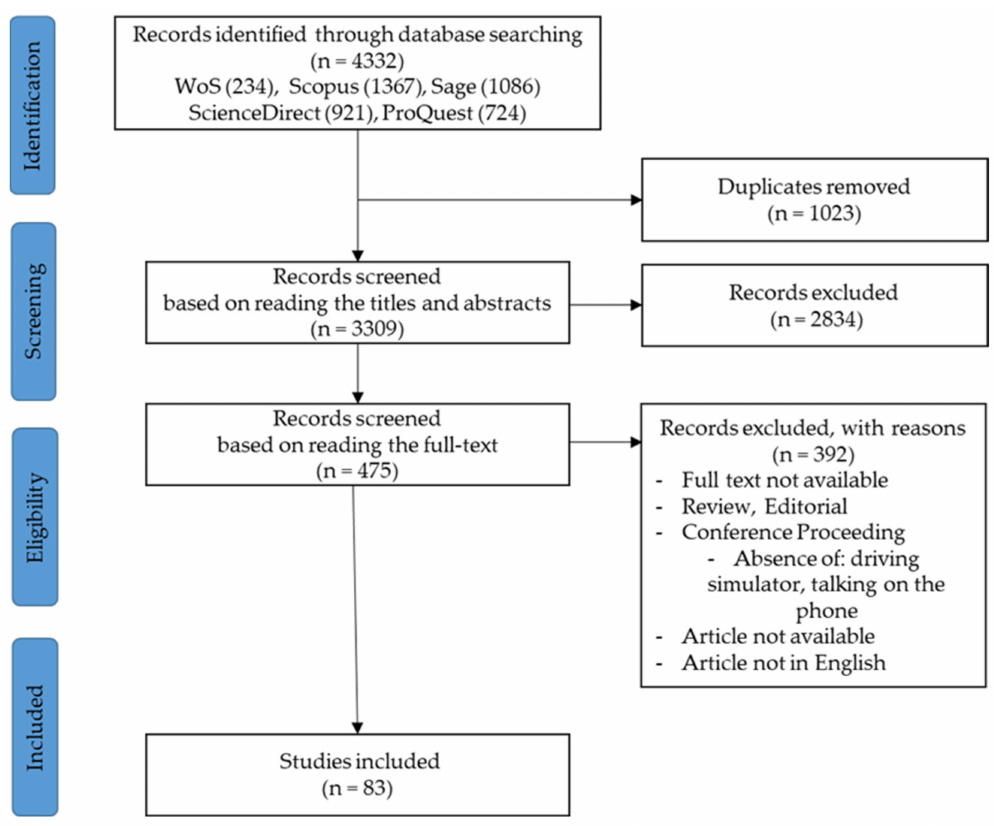
Figure 1. Study selection methodology following the PRISMA flow